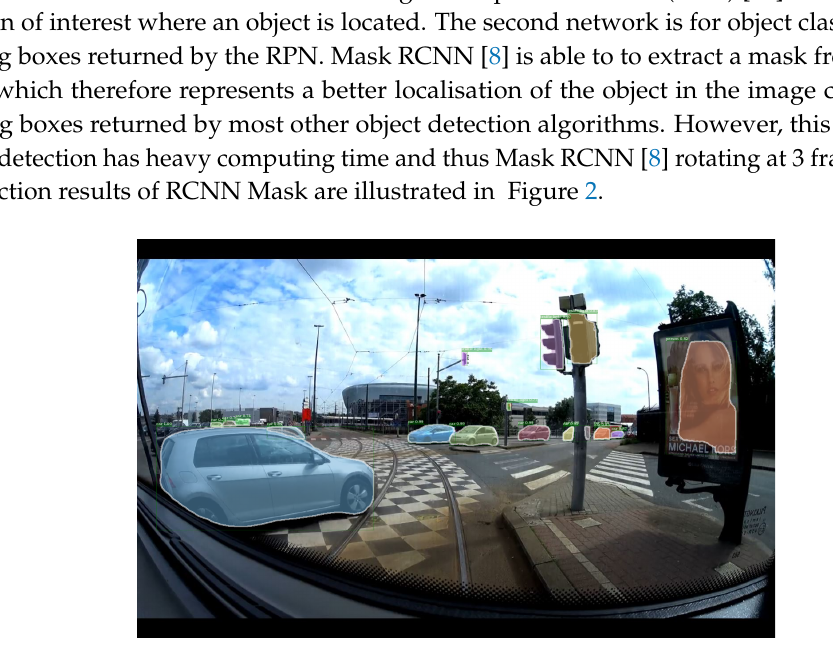
Figure 2. Mask-RCNN results (returns the mask of each detected object with their class and their confidence